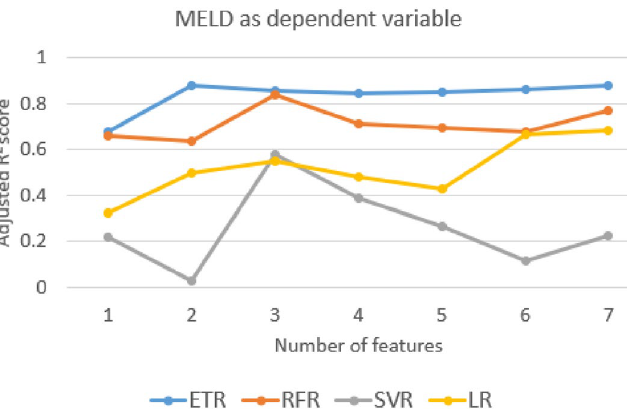
Figure 9. The adjusted R 2 value for different sets of features with MELD score as the dependent